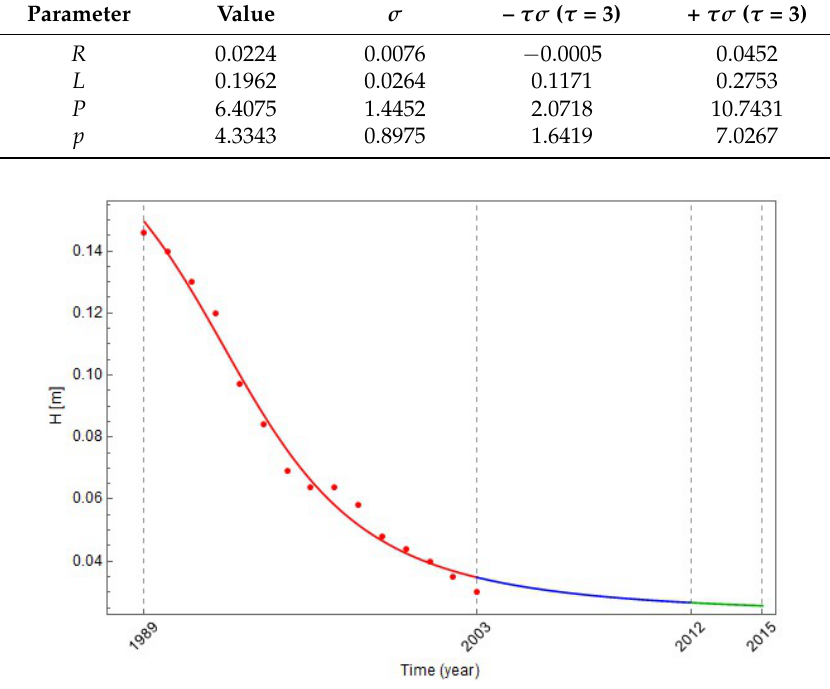
Table 4. Results from the analysis of the vertical displacement of point 367a/4.